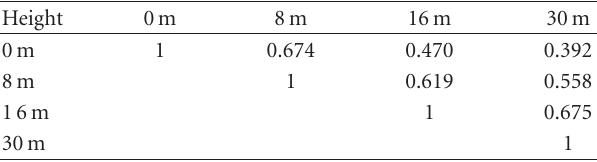
Table 8: Jaccard similarity indices for the four forest strata samples